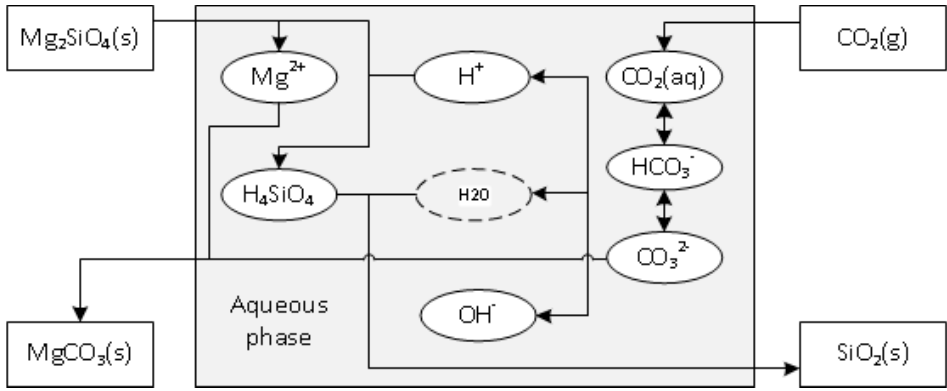
Figure 1. Reaction path of direct forsterite carbonation in aqueous solution.